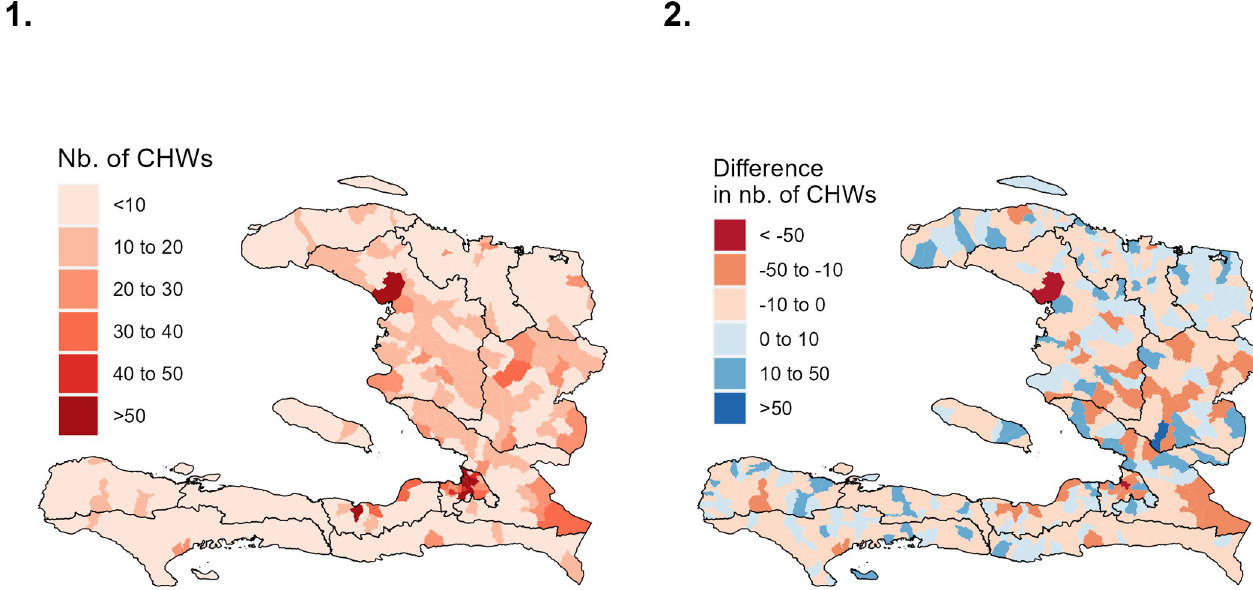
Fig 5. Analysis of scenario C, where CHWs are positioned in the whole territory, accounting for the position of CCSs. 1. Number of CHWs per section communale, according to scenario C. 2. Difference by section communale between the current number of CHWs in the SPA survey and the suggested number of CHWs under the scenario C. Negative values (signified in red) indicate a deficit, positive values (in blue) signify a surplus. The shapefile from the Centre National de l’Information Ge´o-Spatiale (CNIGS) was used [30] (available at